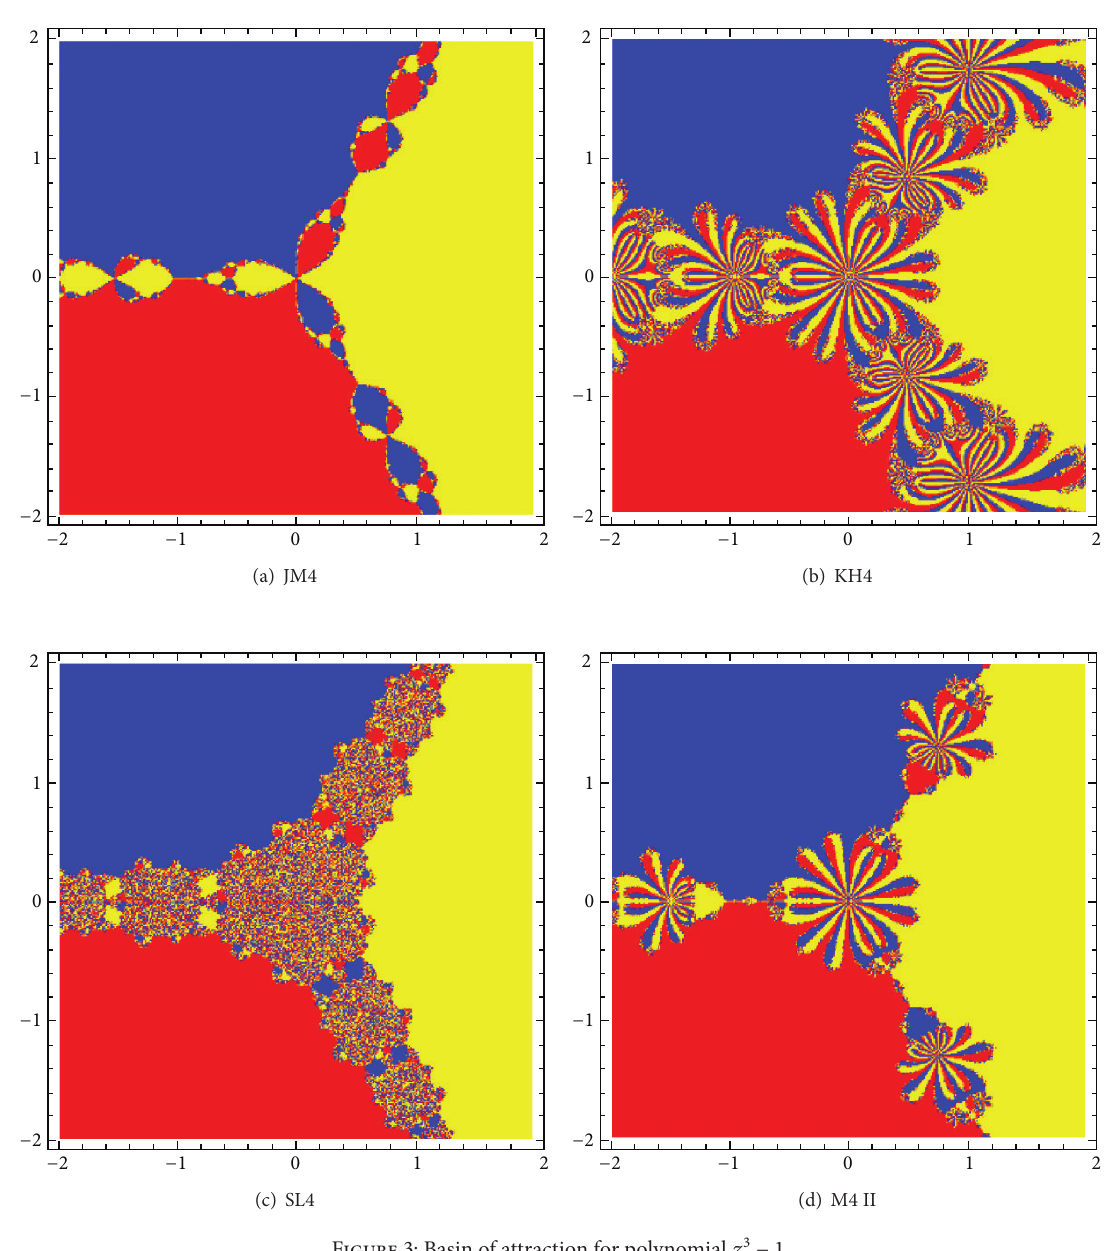
Figure 3: Basin of attraction for polynomial 𝑧 3 − 1